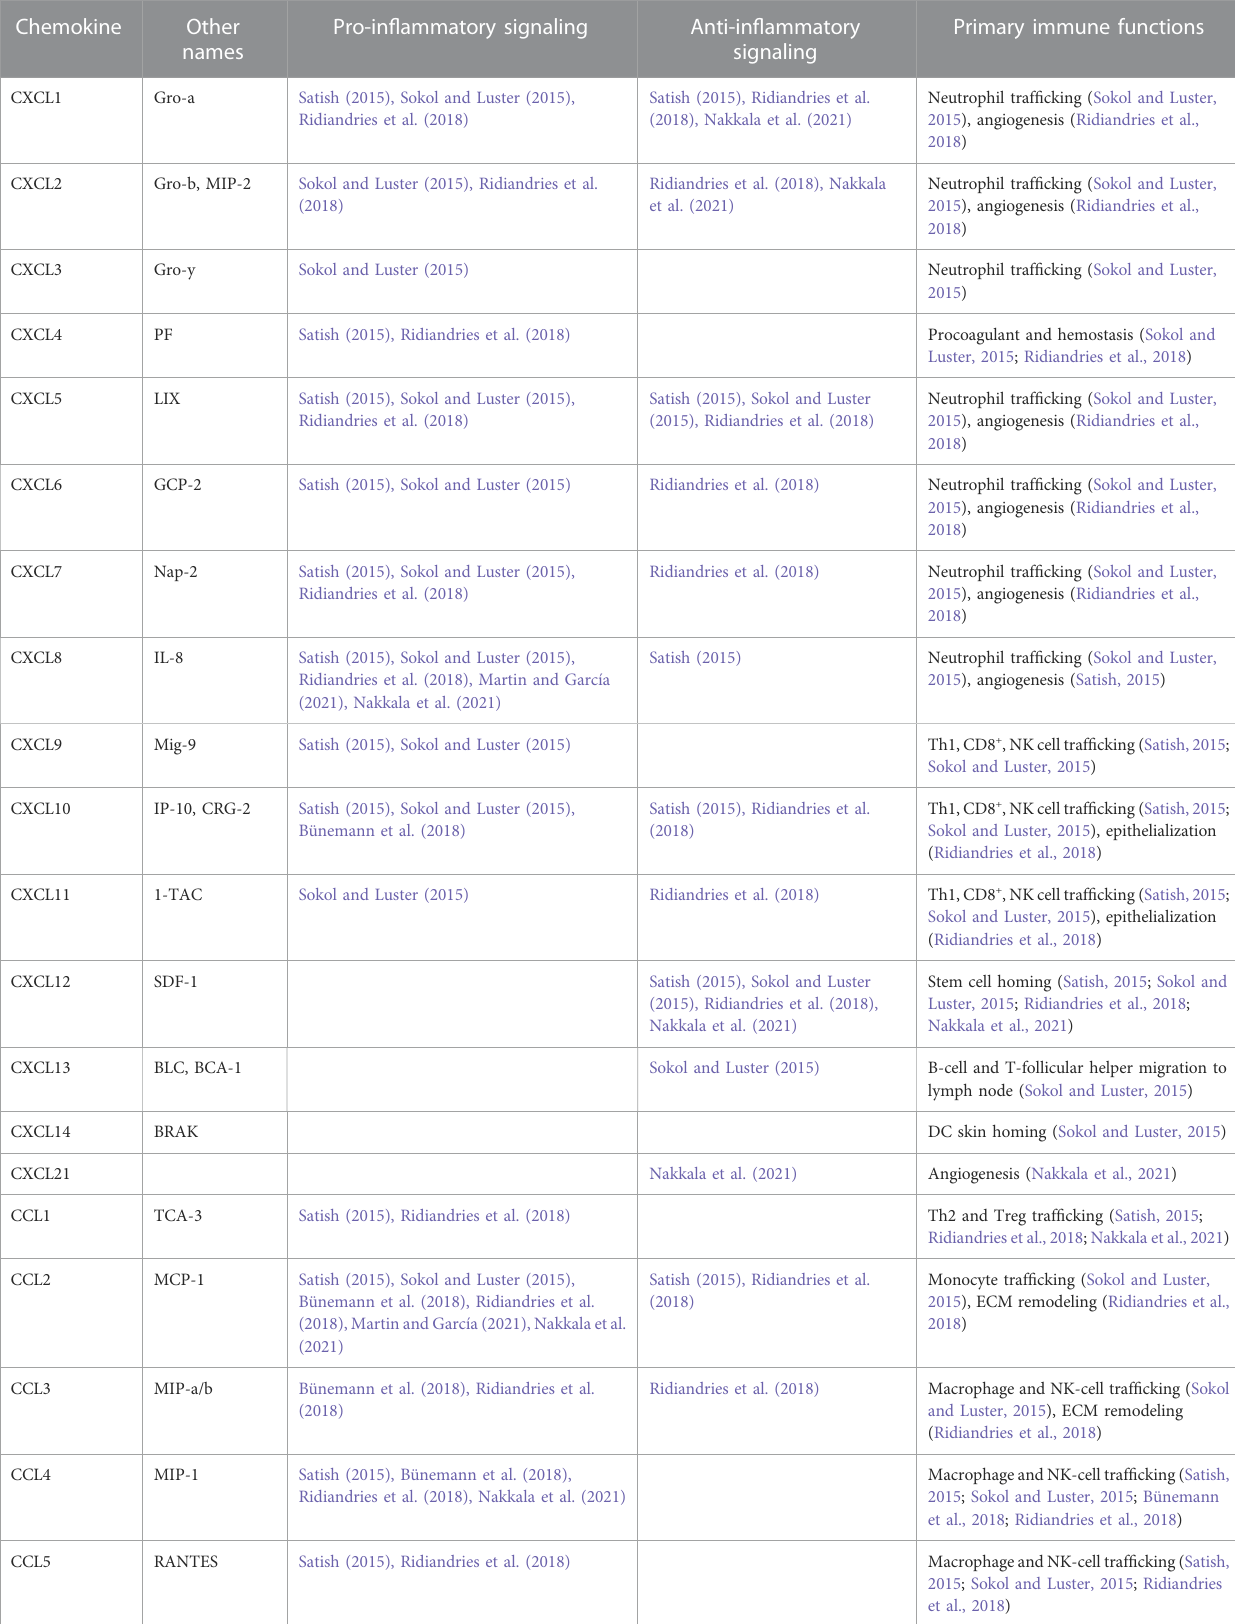
TABLE 1 A list of chemokines with presumed signaling pro fi les and immune functions in skin wound healing. Th, T helper; NK cell, natural killer cell; DC, dendritic cell; LN, lymph node.